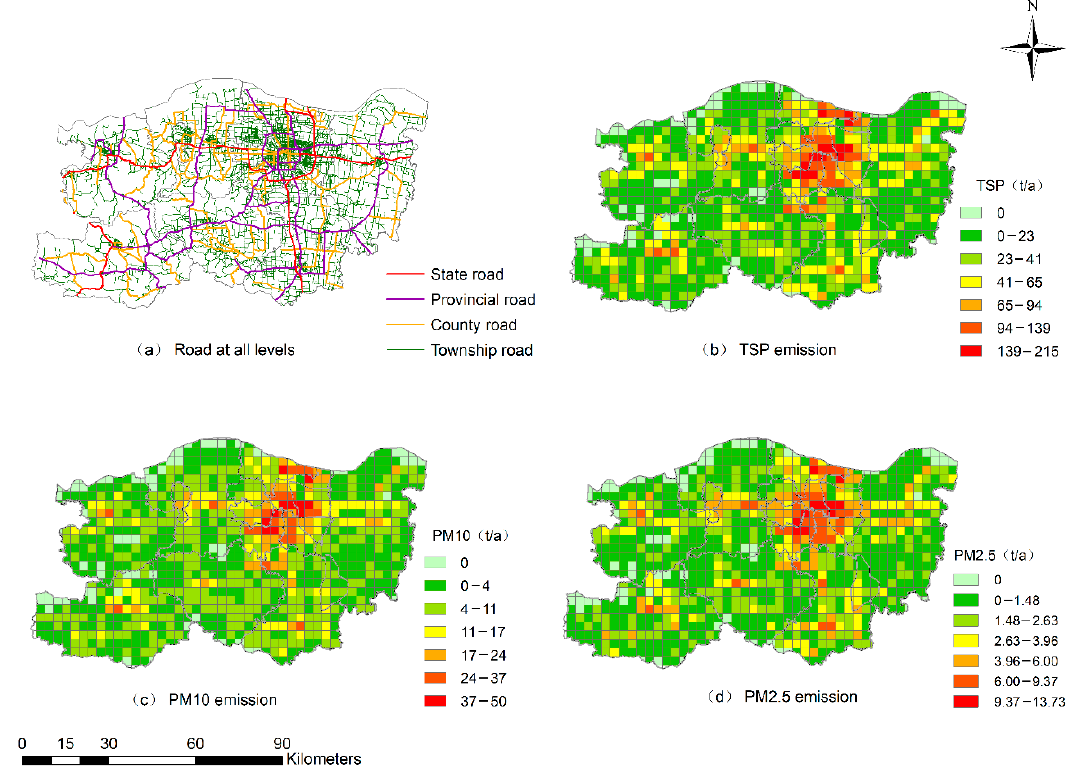
Table 2. Emission of TSP, PM 10 and PM 2.5 from road dust source.